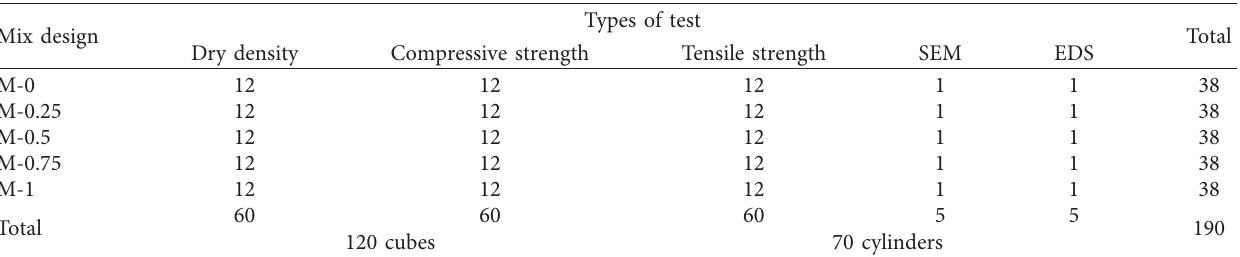
Table 2: Quantity of specimens